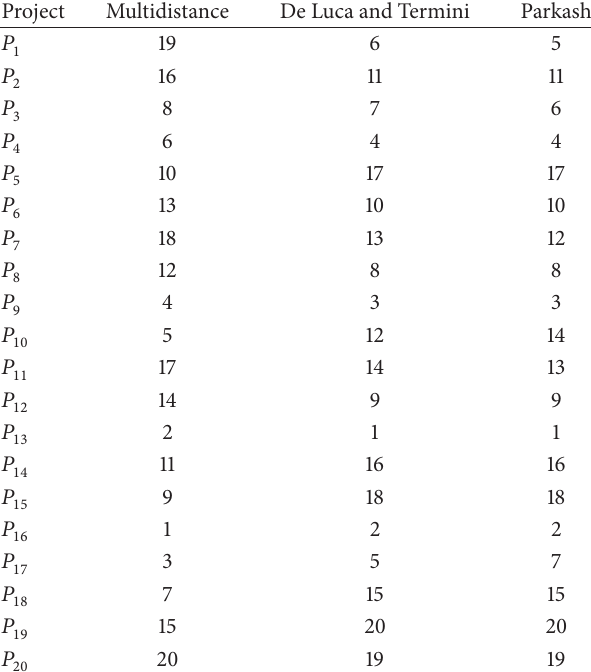
Table 3: Overall rankings of the R&D projects with multidistance, De Luca and Termini entropy measure and with Parkash entropy